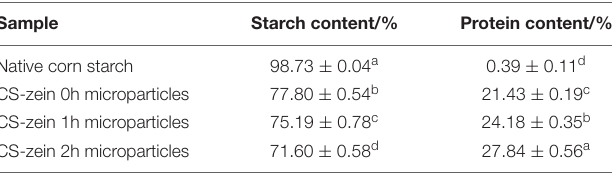
Values indicate means ± SD of three replicates. Data in the same column with different letters are substantially different (p <